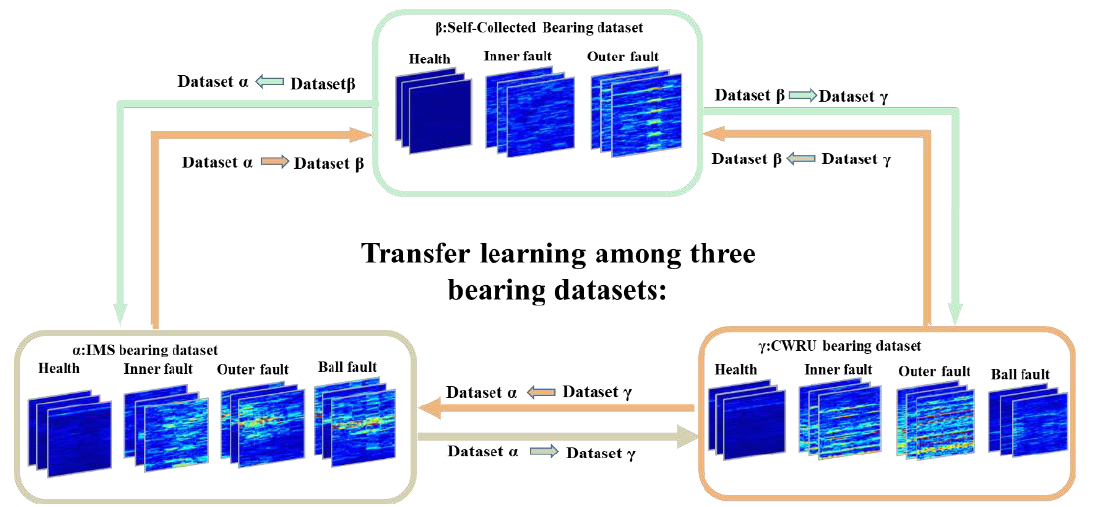
Figure 9. Transfer pipeline of the proposed framework. Dataset α → dataset β denotes that we utilized the α as the source domain and the β as the target domain.